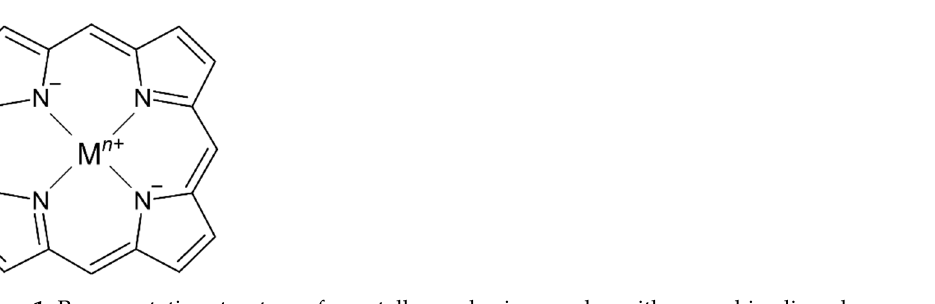
Figure 1. Representative structure of a metalloporphyrin complex with a porphine ligand core.